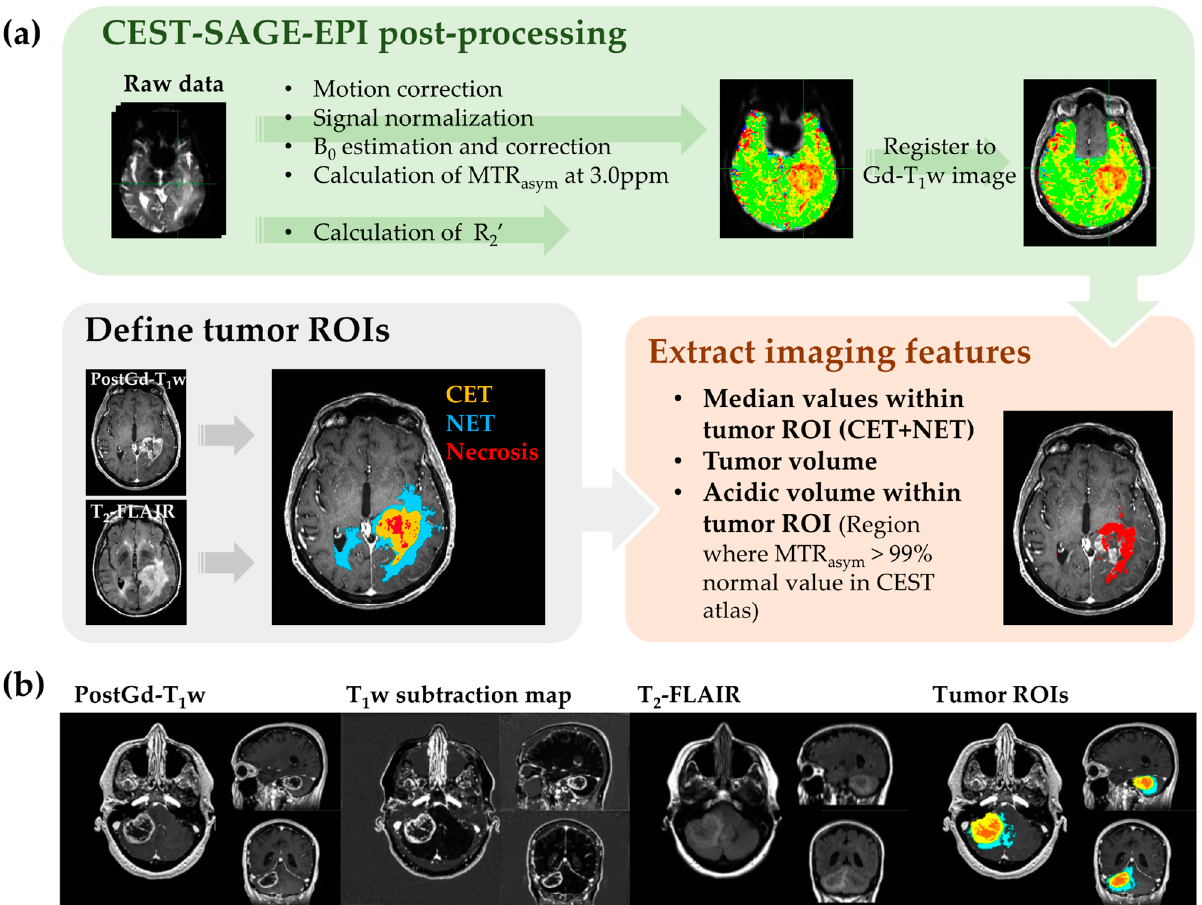
Figure 1. Workflow diagram of CEST-SAGE-EPI data processing and feature extraction. The image post-processing procedure is described in ( a ). ( b ) Demonstrates an example of tumor ROIs delineated semi-automatically using T 1 -weighted subtraction maps and T 2 -weighted FLAIR images, with the yellow ROI representing the contrast-enhancing tumor, red representing the region of central necrosis, and cyan showing the non-enhancing tumor (or edema) region.